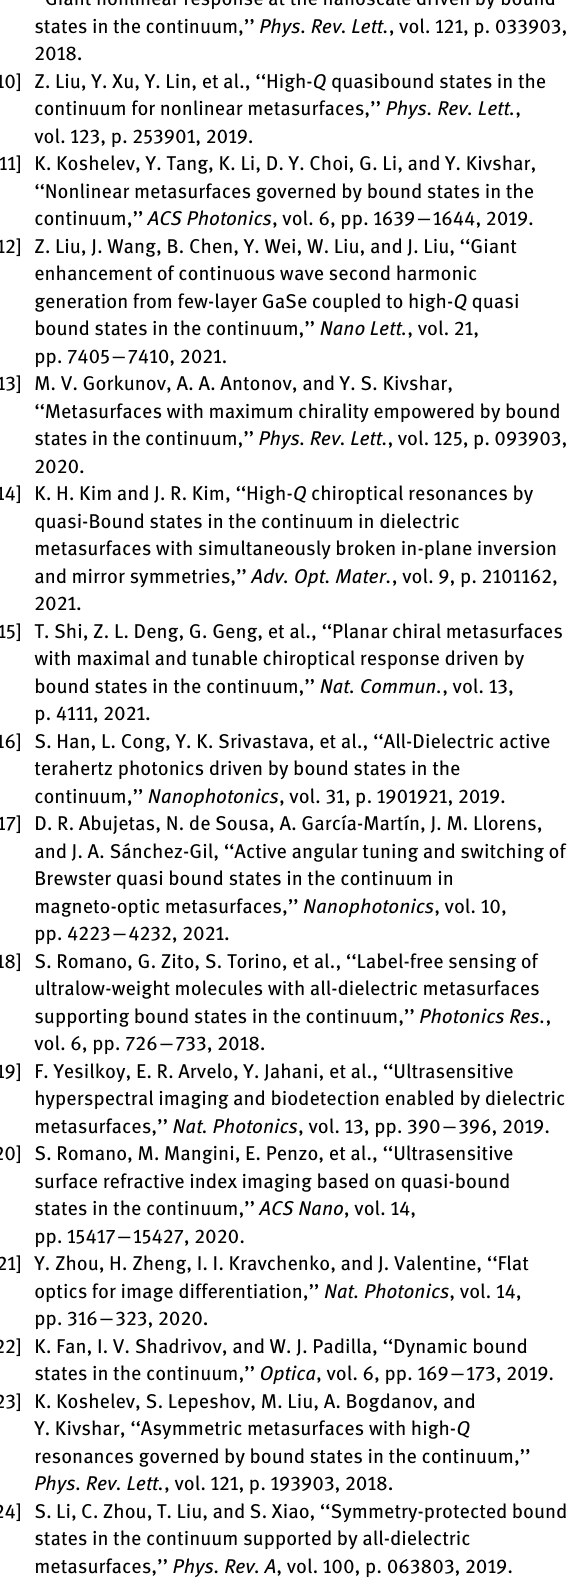
4852 | X. Du et al.: Dual-band BICs based on SLR